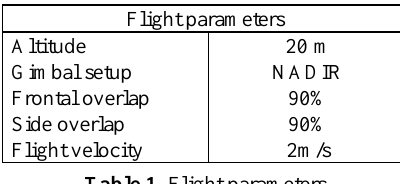
Table 1 . Flight parameters During the flight mission count of RGB and TIR images was 244. Flight velocity was setup on minimum. High velocity causes image deformation on camera without mechanical